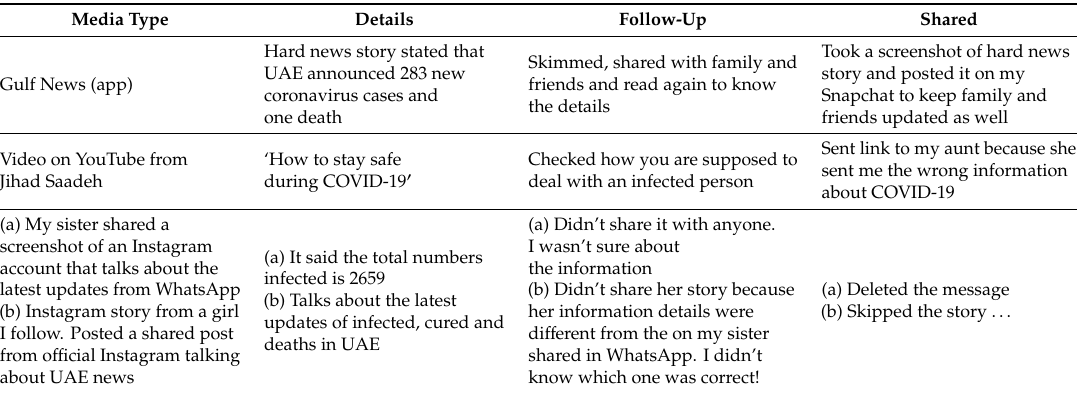
Table 6. Examples of sharing